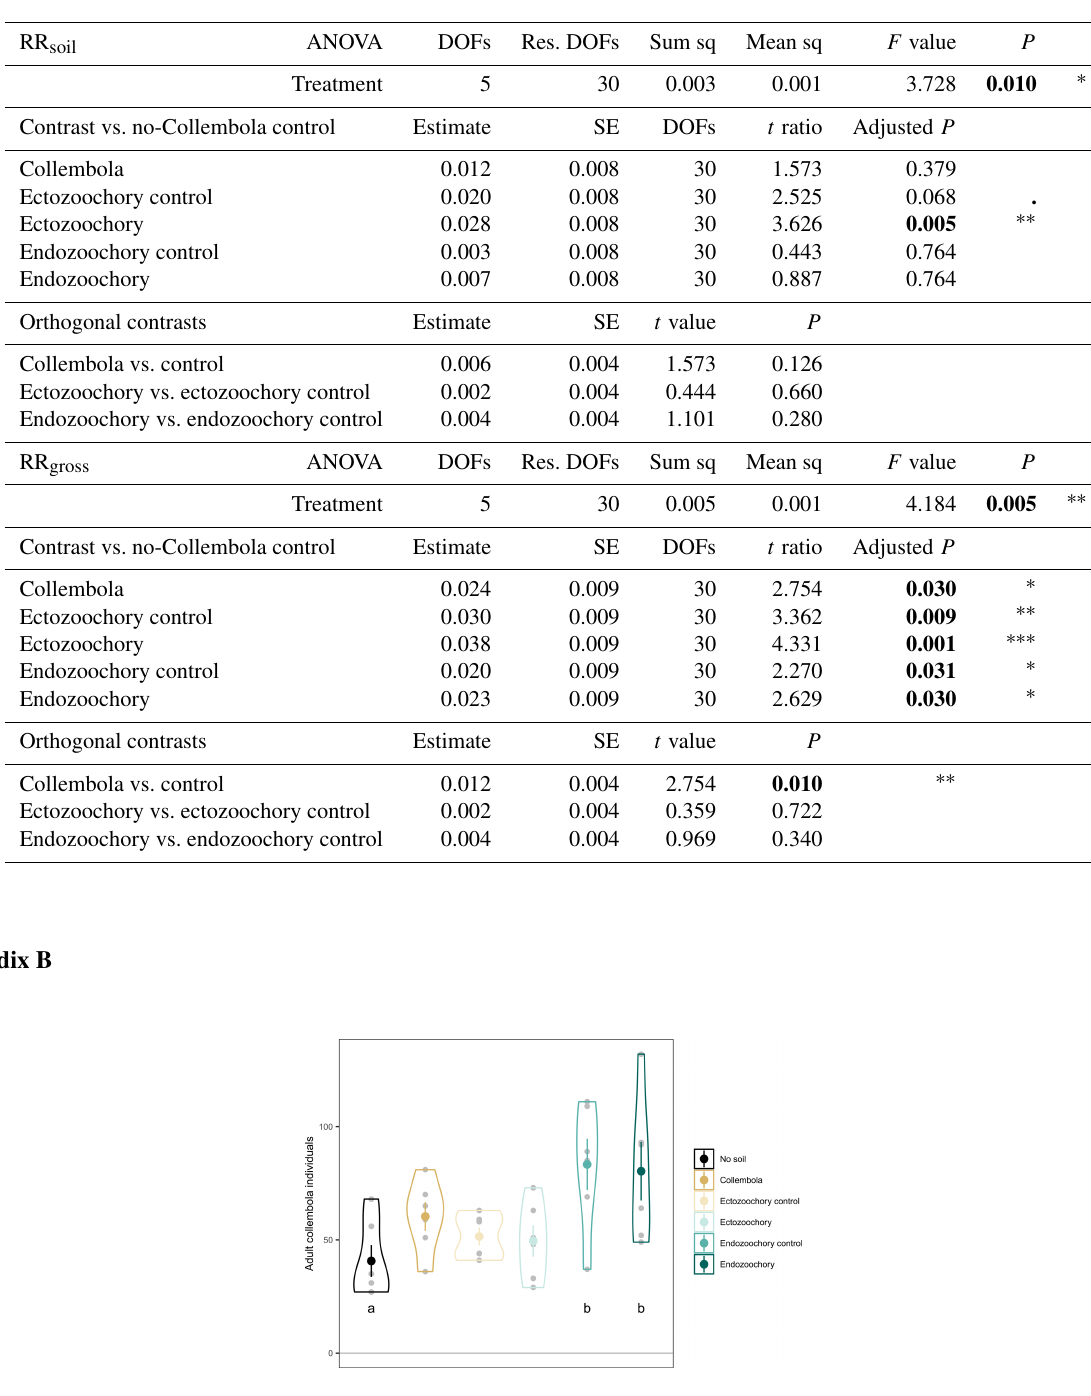
Table A2. Effects of Collembola additions on response ratios of cumulative CO 2 production at the end of the incubation, excluding (RR soil ) or including (RR gross ) estimated Collembola respiration. Holm adjustment for P values of non-orthogonal contrasts. P values below 0.05 are denoted in bold; ∗∗∗ P < 0.001; ∗∗ 0.001 <P < 0.01; ∗ 0.01 <P < 0.05; dot ( · ) denotes 0.05 <P < 0.1. DOFs: degrees of freedom; Res. DOFs: residual degrees of freedom.